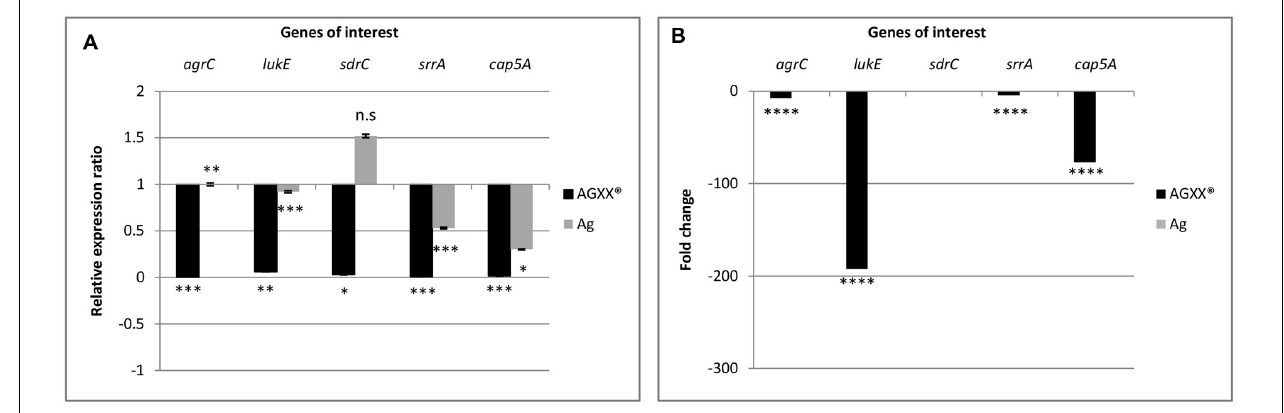
FIGURE 7 | Differential expression of agrC , lukE , sdrC , srrA , and cap5A in S. aureus 04-02981 on 80-min exposure to Ag or AGXX R (cid:13) , obtained via RT-qPCR. Expression ratio of the genes of interest in S. aureus 04-02981 on exposure relative to control (untreated culture of S. aureus 04-02981) normalized to gyrB are shown (A) . (B) Shows differential expression of agrC , lukE , sdrC , srrA , and cap5A in S. aureus 04-02981 on 80-min exposure to Ag or AGXX R (cid:13) , obtained via RNA-seq as fold change. Error bars indicate standard deviation. Asterisks indicate p -values showing statistical significance. They were obtained from t -test using SigmaPlot 11.0 ( ∗∗∗∗ p < 0.0001, ∗∗∗ p < 0.001, ∗∗ p < 0.01, ∗ p < 0.05; n.s, not